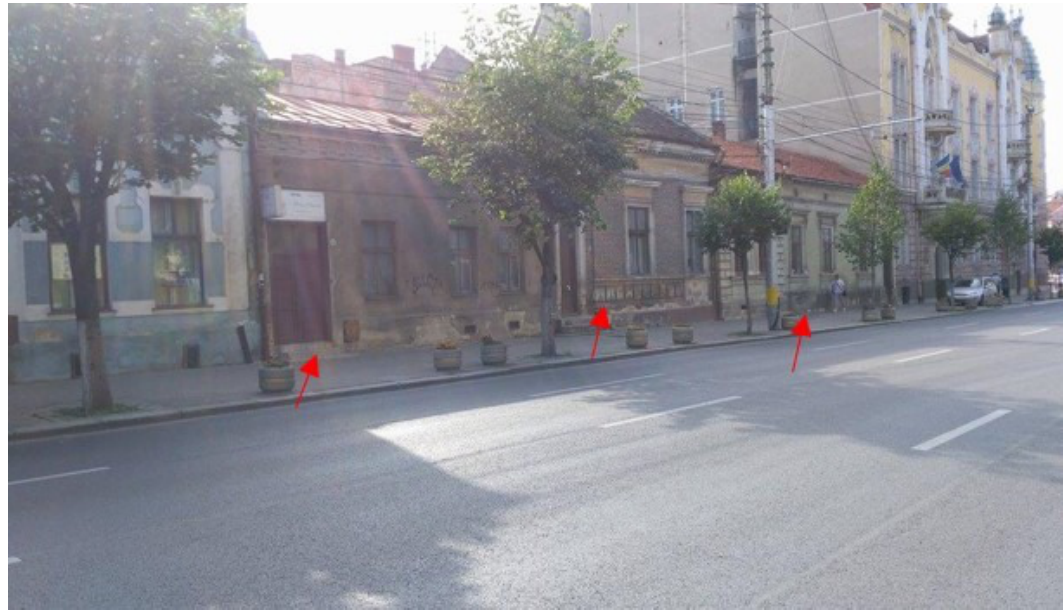
Figure 17: “ Phantom spaces” in Avram Iancu Square Source: Emanuel- Cristian ADOREAN,